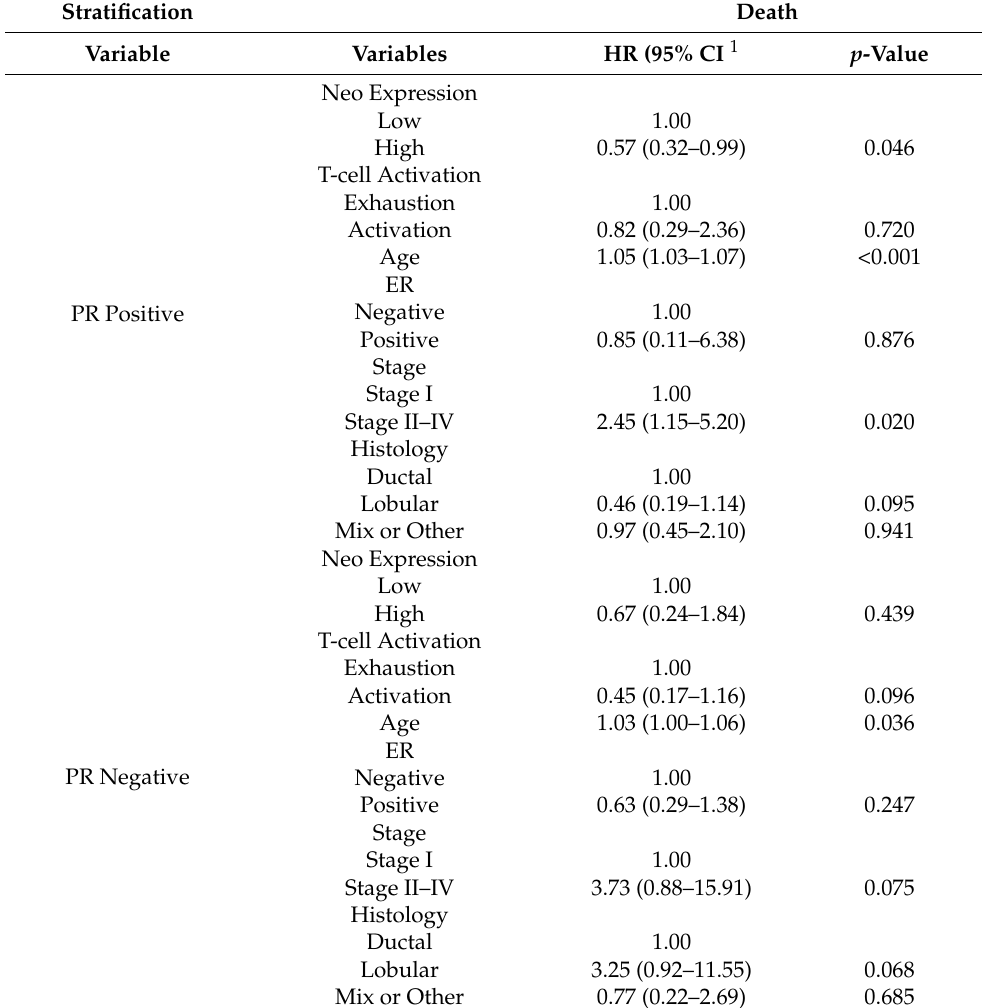
Table 5. Association between neoantigen expression and overall survival stratified by PR